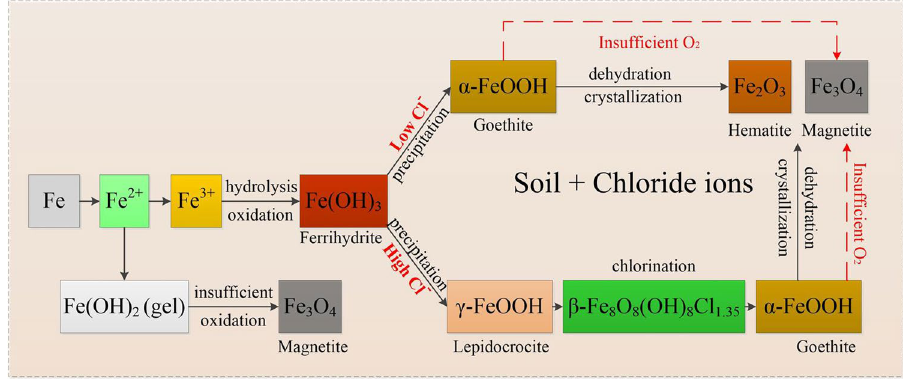
Figure 5. The potential transformation processes of ferrous metals in soils with different chloride contents.